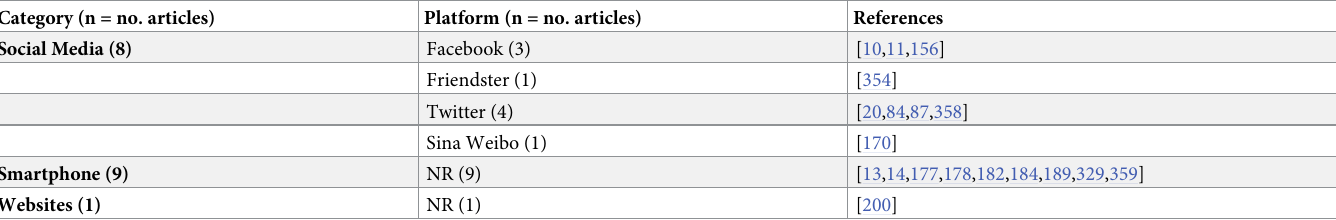
Table 11. Number of articles predicting family and relationship status, with associated platforms and references. Category (n = no. articles)